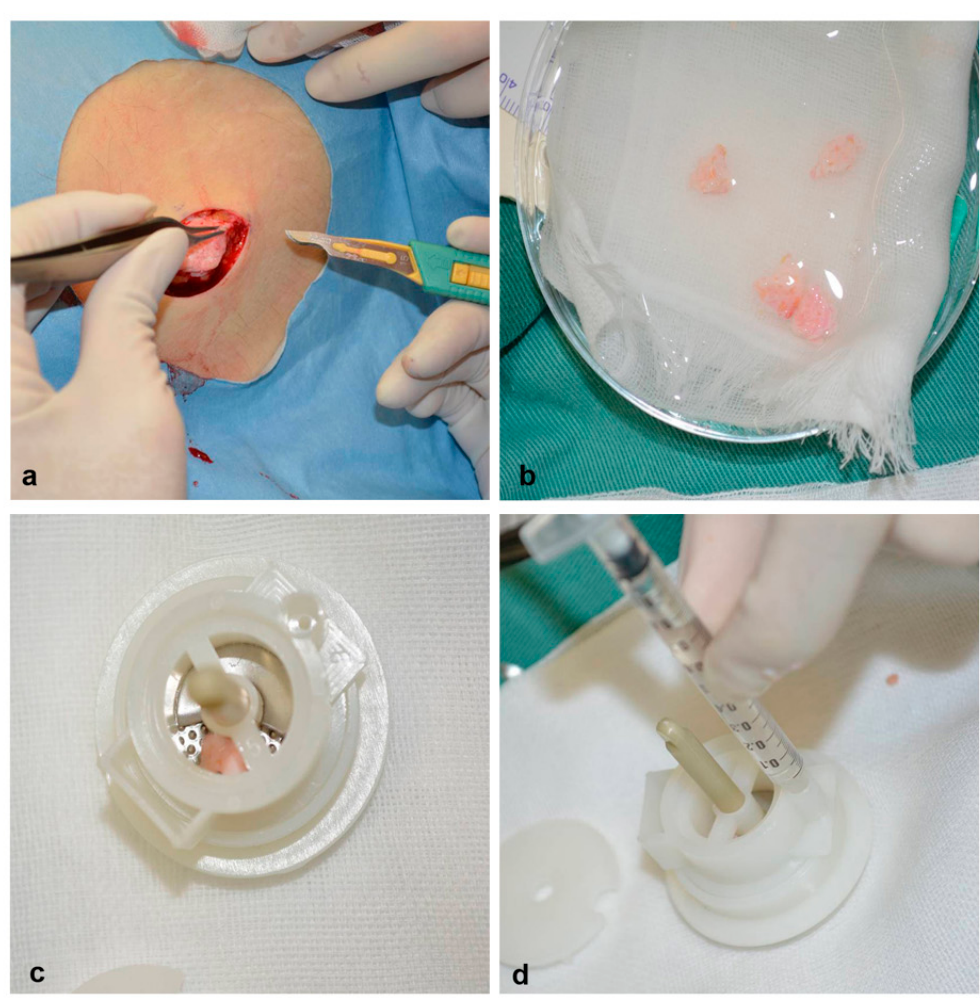
Figure 1. In order to use the Rigeneracons device, a small sample autologous tissue is collected from the outer part of the patient’s thigh ( a ). The dermal component of skin is selected ( b ). The tissue sample along with sterile saline solution are inserted inside the device, later activated for 2 min ( c ).